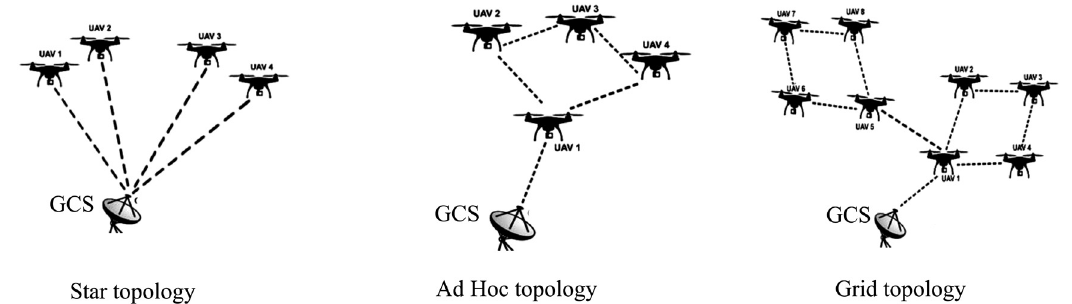
Figure 3: Di ff erent communication architectures [ 39 ]